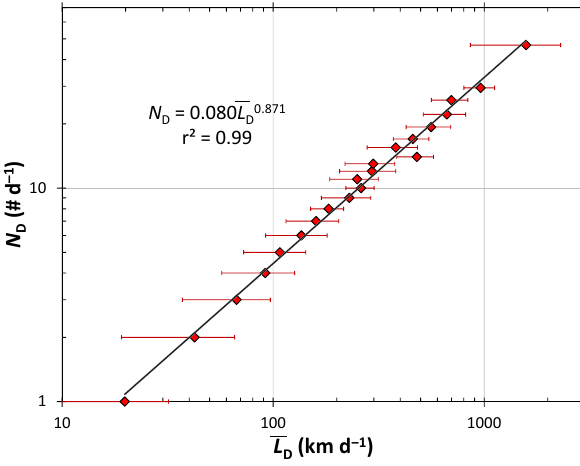
Fig. 14. The total number of severe tornadoes ( L ≥ 10km) in a continental USA “outbreak” N D during the period (1982–2011), is given as a function of L D the mean of the convective daily total tor- nado path lengths for all days where N D is the same value. Daily values are for convective days (12:00–12:00UTC). Horizontal error bars represent ±1 σ (±one standard deviation) of the L D for a given N D . The best-fit power-law correlation of the data is also given (Eq. 16). Tornado path length data L are from NOAA